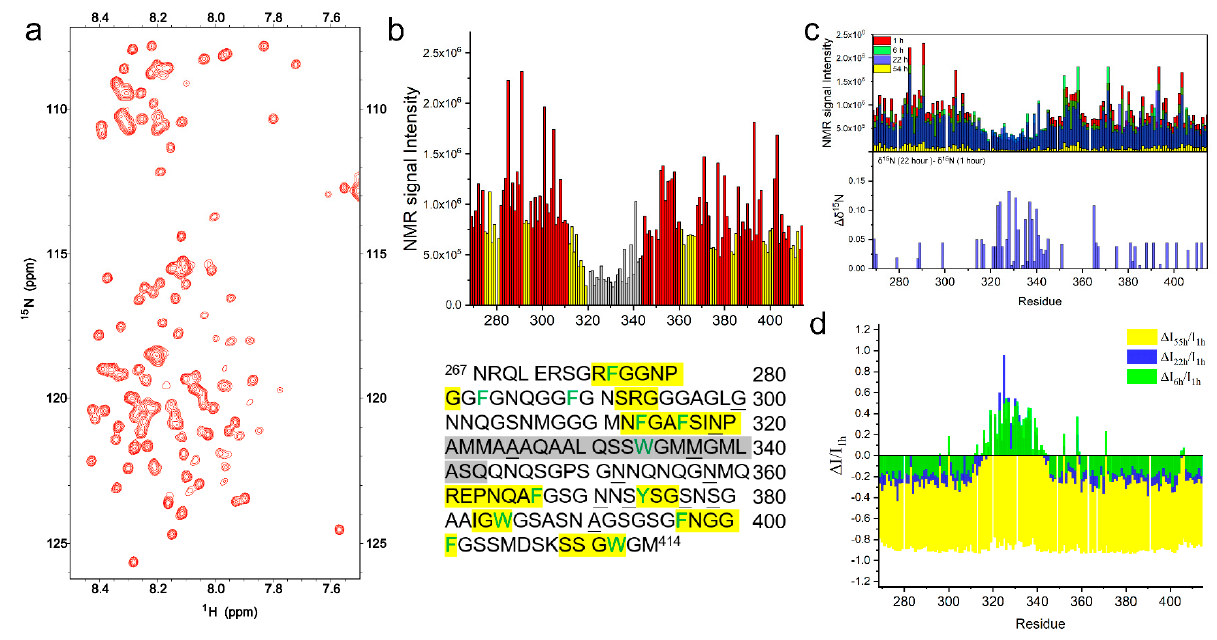
Figure 2. The 1 H- 15 N HSQC spectra of TDP-43 LCD. ( a ) The 1 H − 15 N HSQC spectra of TDP-43 LCD obtained within 2.5 h after the sample preparation at a concentration of 100 µ M in pH 6.0, 10 mM phosphate buffer, and 25 °C. ( b ) The NMR peak intensity for each residue obtained from the 1 H − 15 N HSQC shown in ( a ). Helical region of the TDP-43 LCD (in gray) exhibited the lowest signal intensity, while several short segments (in yellow) also exhibited mild signal loss. The amino acid sequence of TDP-43 LCD was shown at the bottom panel with the corresponding highlighted sequences in gray and in yellow. The aromatic amino acids were in green, and the underlined residues were those showing a higher intensity in the pH 5.5 MES buffer. ( c ) (Top) Comparison of the NMR signal intensity from 1 H − 15 N HSQC spectra of TDP-43 LCD (100 μ M) in pH 6.0, 10 mM phosphate buffer, obtained within 2.5 h from the sample preparation (labeled as I 1h using the approximate starting time, in red) and obtained at ~6 h (I 6h , in green), 22 h (I 22h , in blue), or 53 h (I 55h , in yellow) from the sample preparation. (Bottom) 15 N chemical shift differences ( Δδ 15 N) during TDP − 16 fibrillation in PB. Δδ 15 N = δ 15 N (22nd hour spectrum in PB) −δ 15 N (1 st hour spectrum in PB). ( d ) NMR signal loss ratio ( Δ I/I 1h ) over time, where Δ I represents the NMR signal intensity after ~6 h, 22 h, or 53 h (I 6h , I 22h or I 55h ) minus I 1h .